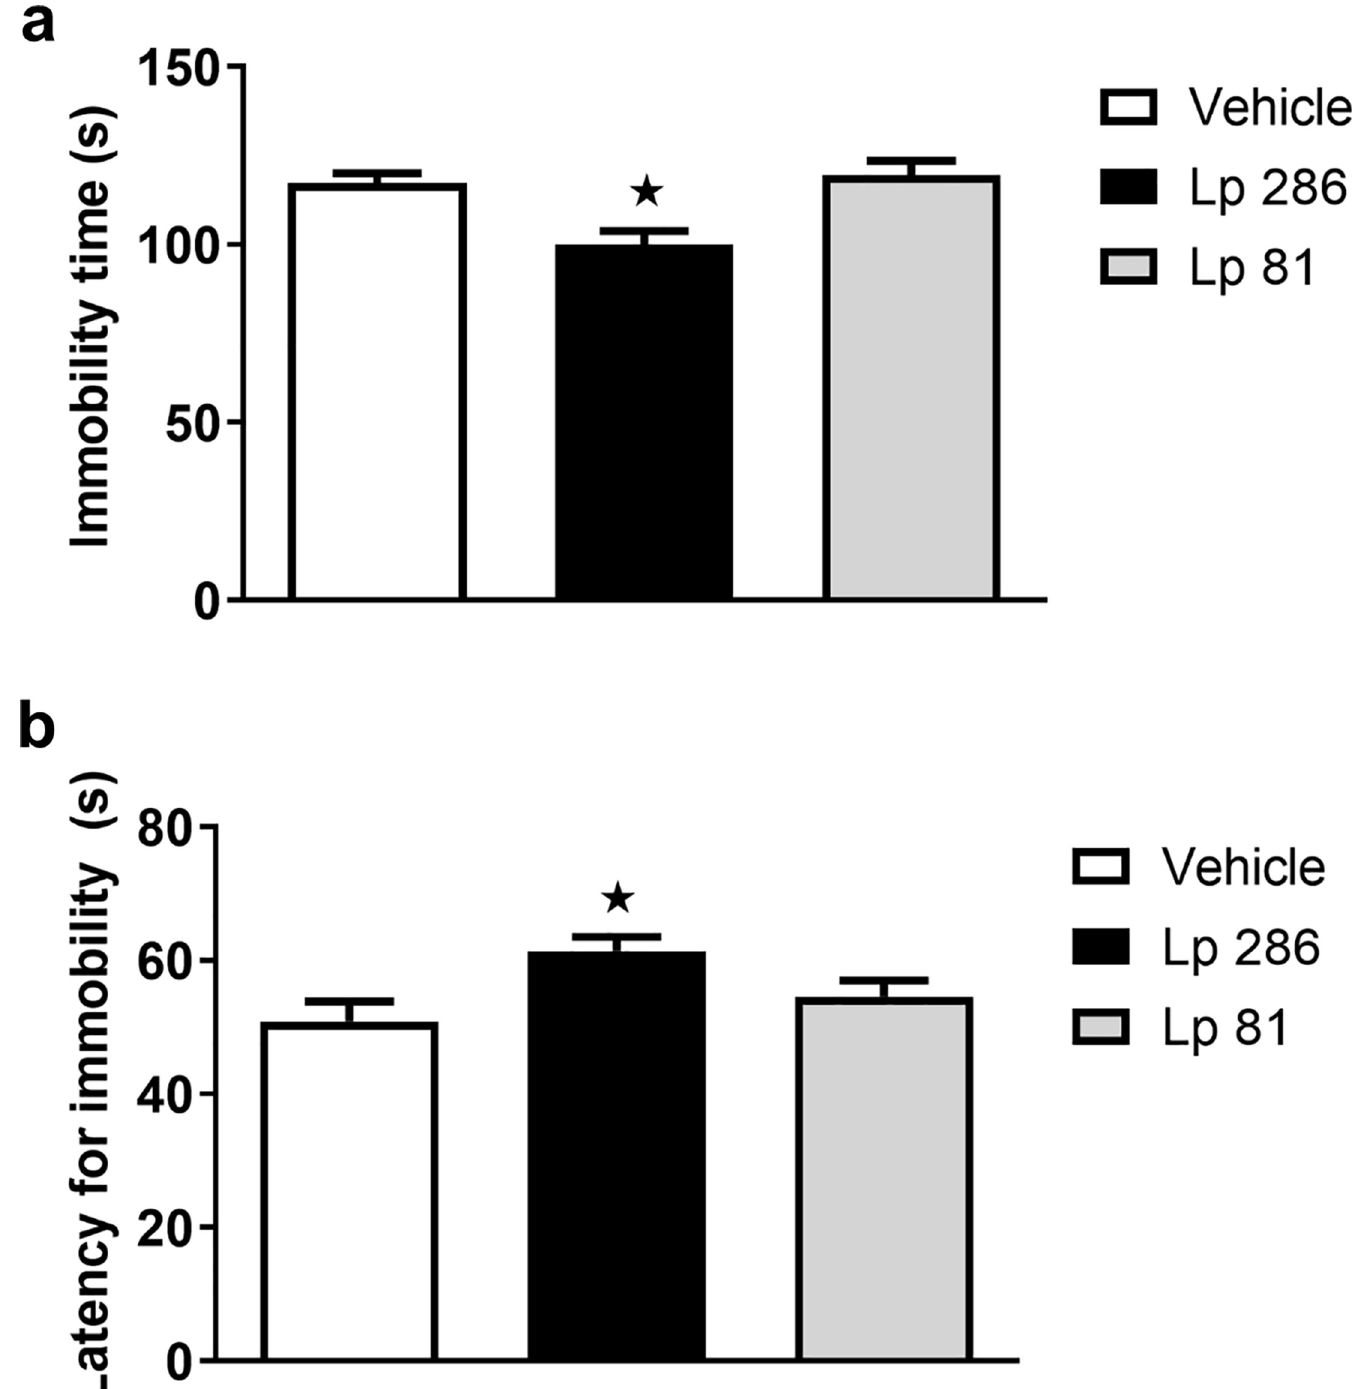
Fig 3. (a) Immobility time (b) and latency for immobility during the forced swim test performed after 30 days of once/daily treatment (oral gavage) with vehicle, Lactobacillus plantarum 286 (Lp 286, 10e9UFC/0.1 mL) or Lactobacillus plantarum 81 (Lp 81, 10e9 UFC/0.1 mL) solutions. Data are presented as mean ± SEM. One- way ANOVA followed by Bonferroni t-test. � p < 0.05 compared to the vehicle group.